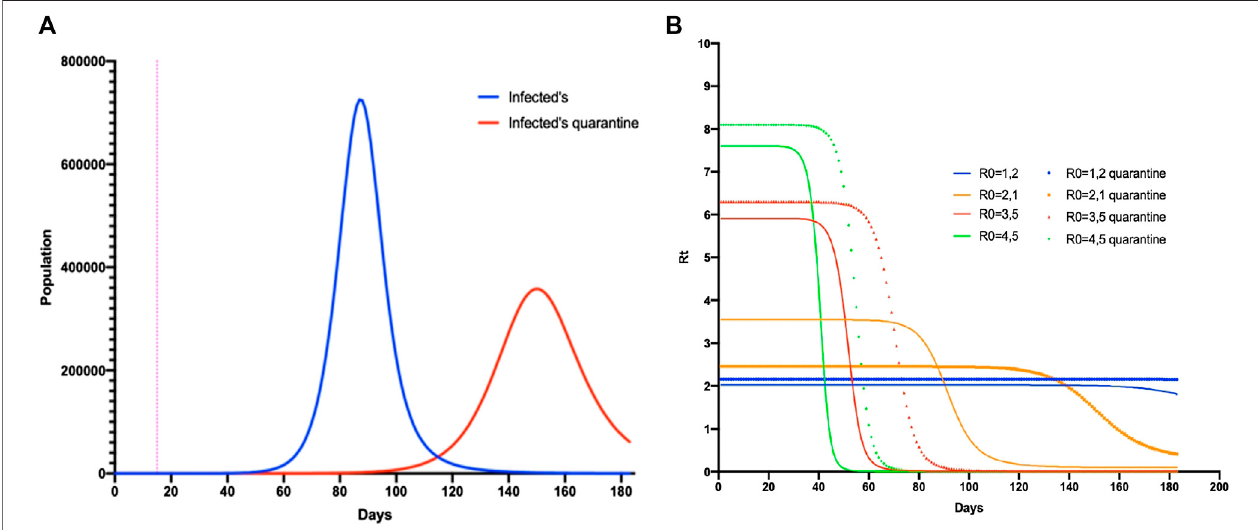
FIGURE 7 | SIR1 model comparing regular parameters with quarantine. In (A) the simulation of Rt is observed in the SIR1 model varying the parameters with and without quarantine throughout the epidemic duration. (B) shows the number of infections without quarantine (blue) and with quarantine (red).